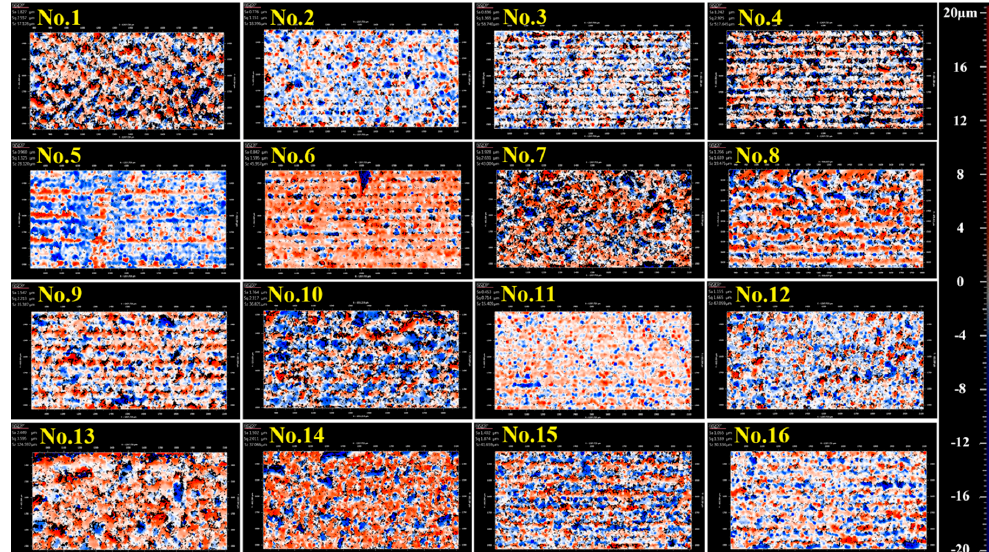
Figure 3. Side-surface images of laser-dicing samples under different parameters measured with white surface interferometer, wherein the red and blue points correspond to the peak and valley, respectively. The number located at each sample represents the experimental number in Table 1. Table 2. Experimental results for lithium niobate (LiNbO 3 ) dicing characteristics under different parameters.